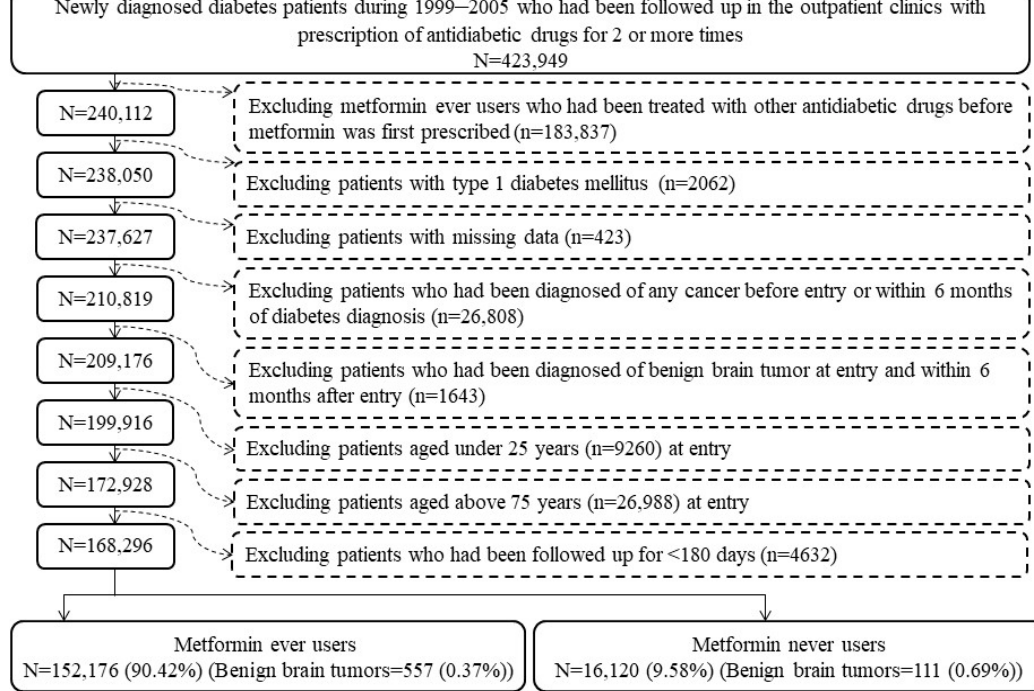
Figure 1. The step-by-step procedures followed in the creation of a cohort of ever users and never users of metformin derived from the Taiwan’s National Health Insurance.